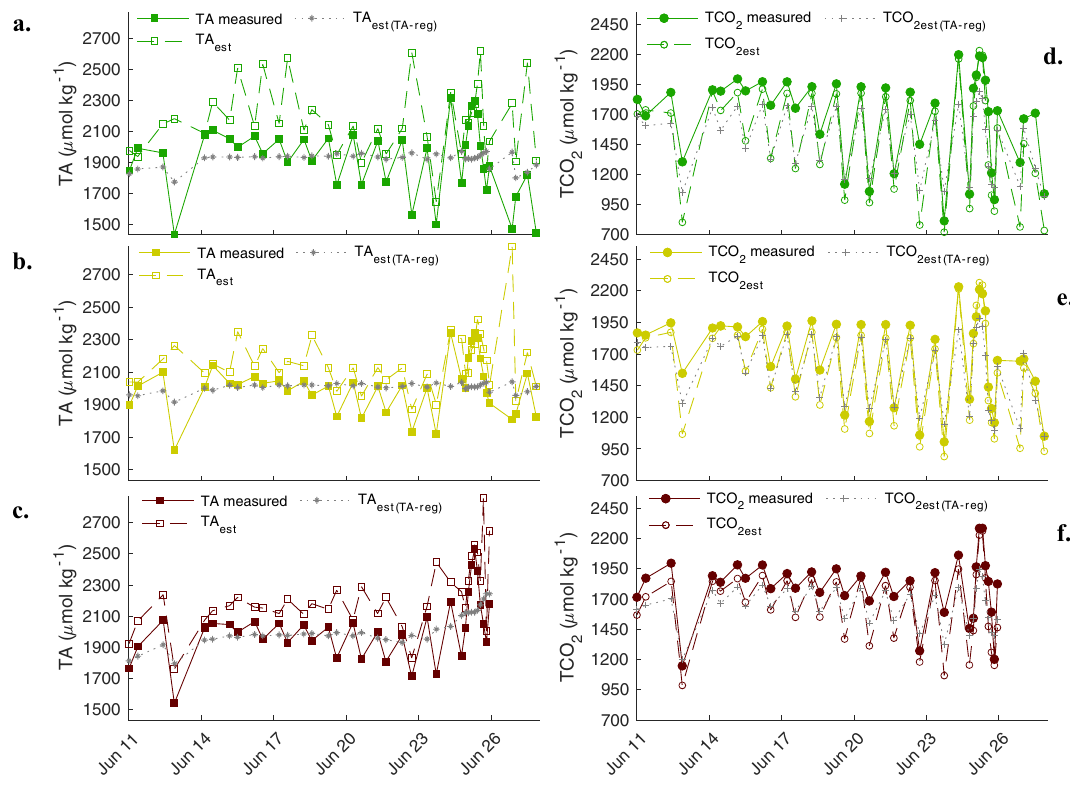
Figure 5. Measured TA (closed squares) along with TA estimated from pH T and TCO 2 (open squares) and TA-salinity regression (grey *) for the DG ( a ), PG ( b ), and NG ( c ), pools. TCO 2 measured values (closed circles) along with TCO 2 estimated from pH T and TA (open circles) and from pH T and TA derived from TA-salinity regression (grey +) for DG ( d ), PG ( e ), and NG ( f )